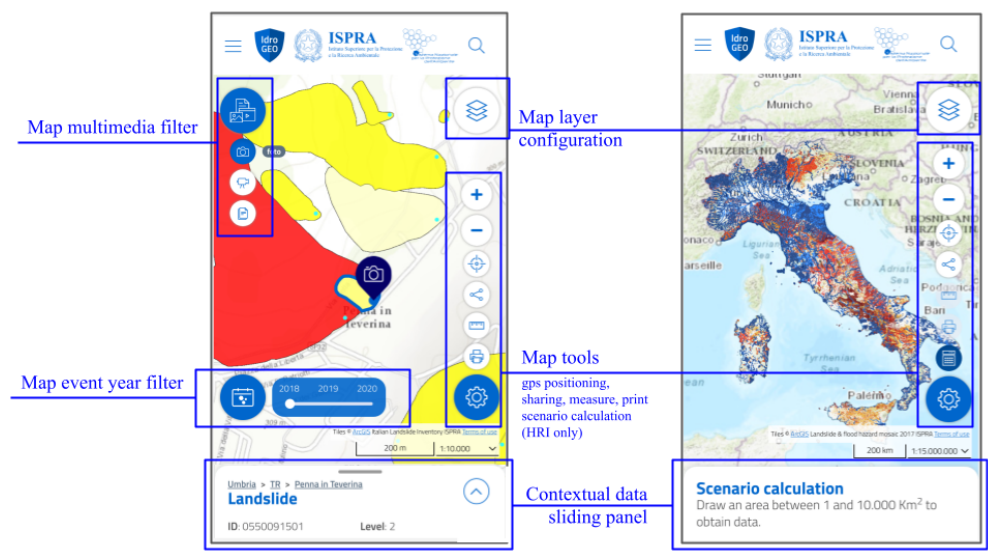
Figure 8. User interface on the mobile screen.